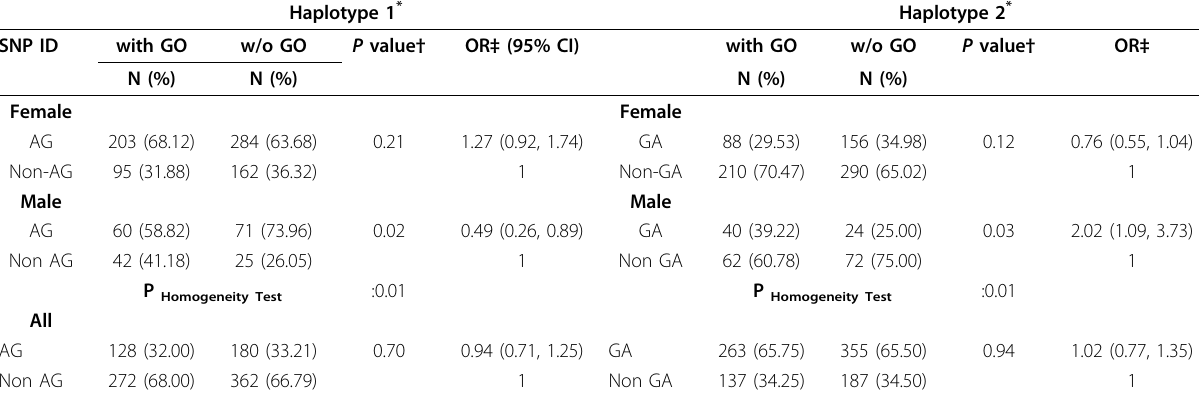
Table 3 The Haplotype Frequency of TLR-9 Gene Stratified by Sex among Graves ’ Disease Patients in